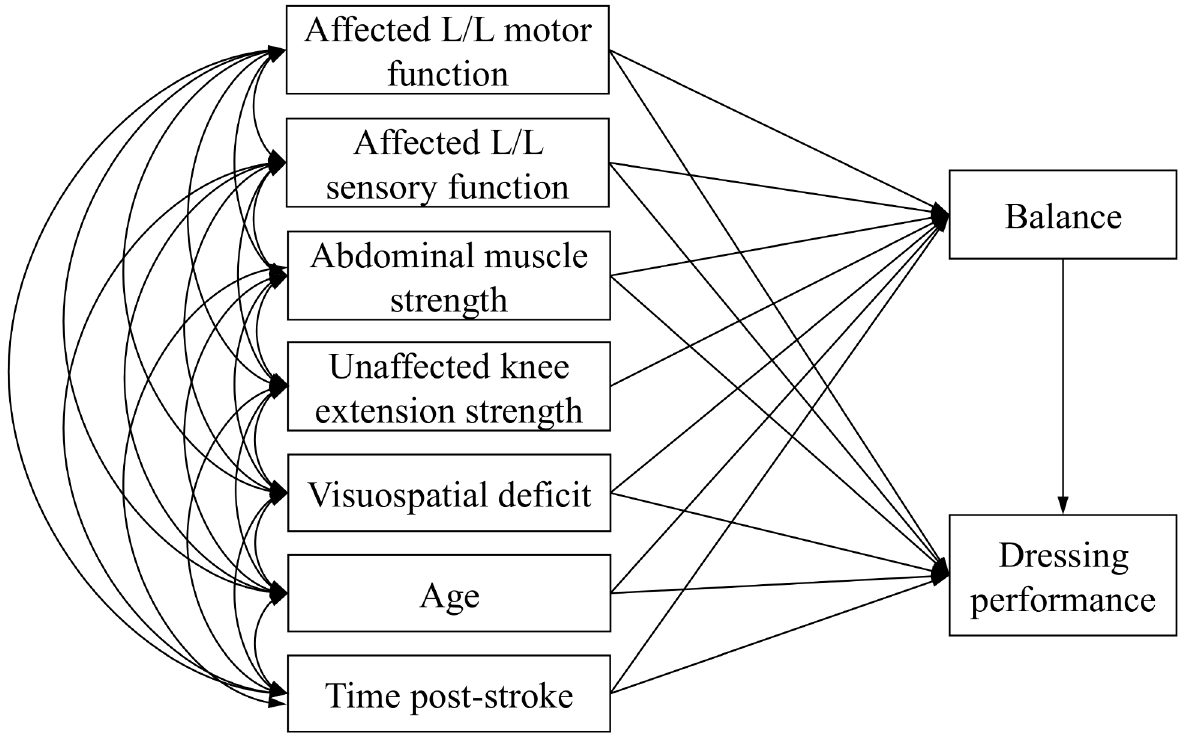
Fig 1. Path diagram of the relationship between the level of independence in dressing and physical and visuospatial dysfunctions. Abbreviations: L/L, Lower limb.